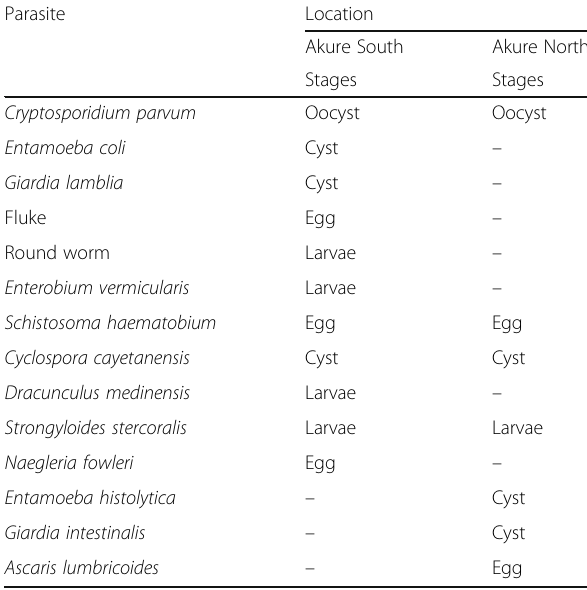
Table 2 Parasites stages found in different drinking water sources in Akure South and North